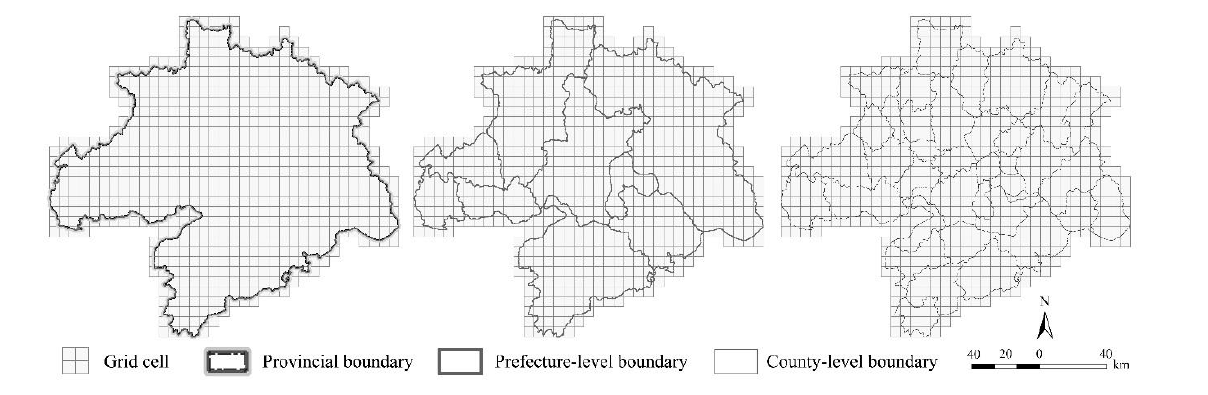
Figure 4. Inequality evaluation based on calculating the sum of pixel values within the administrative units at different geographical